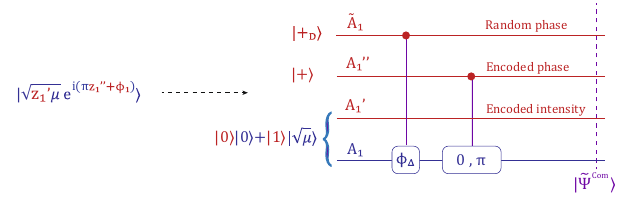
Fig. 4 Source-replacement procedure for the mode-pairing scheme. We substitute the encoding of all random encoded information into the introduction of puri fi ed ancillary